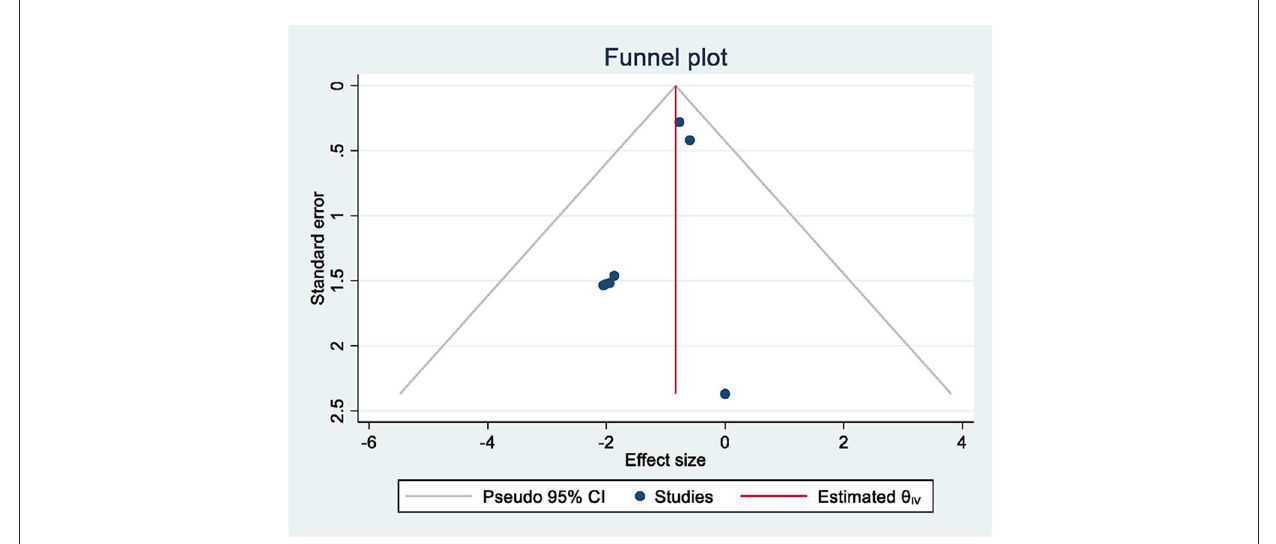
FIGURE4 Funnel plot of all studies that investigated dexmedetomidine (vs.